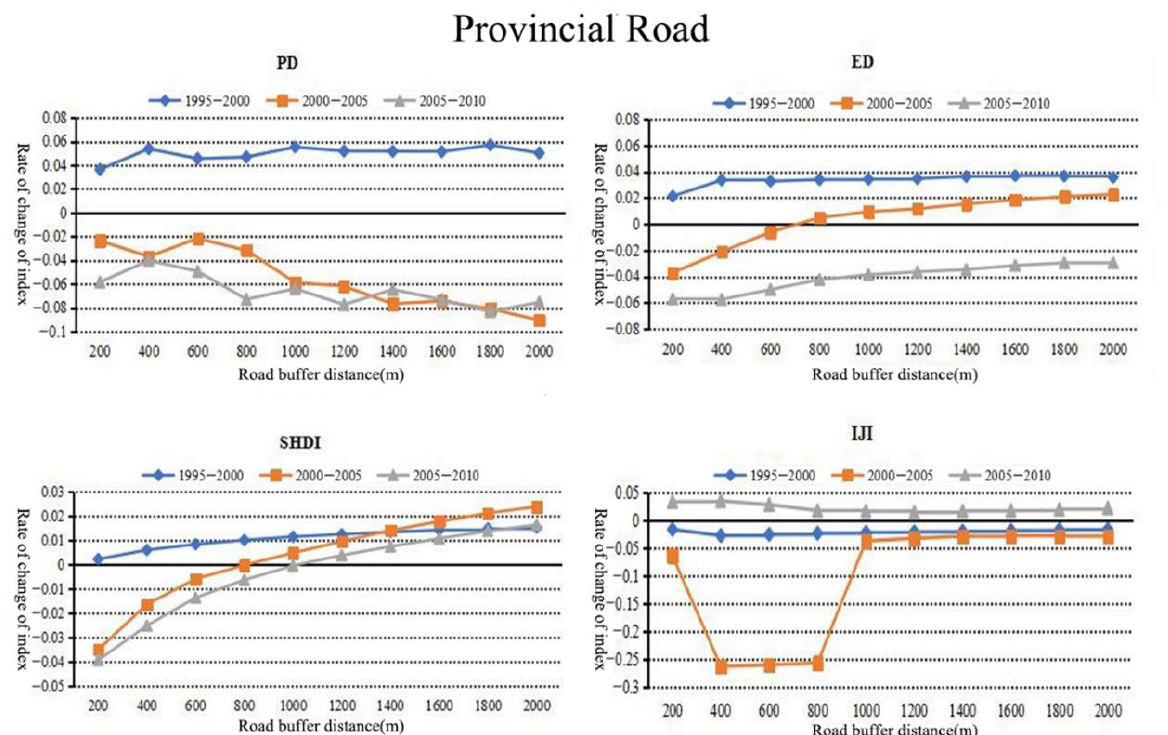
Figure 5. Graph of correlation between index change rate and buffer distance (national roads).